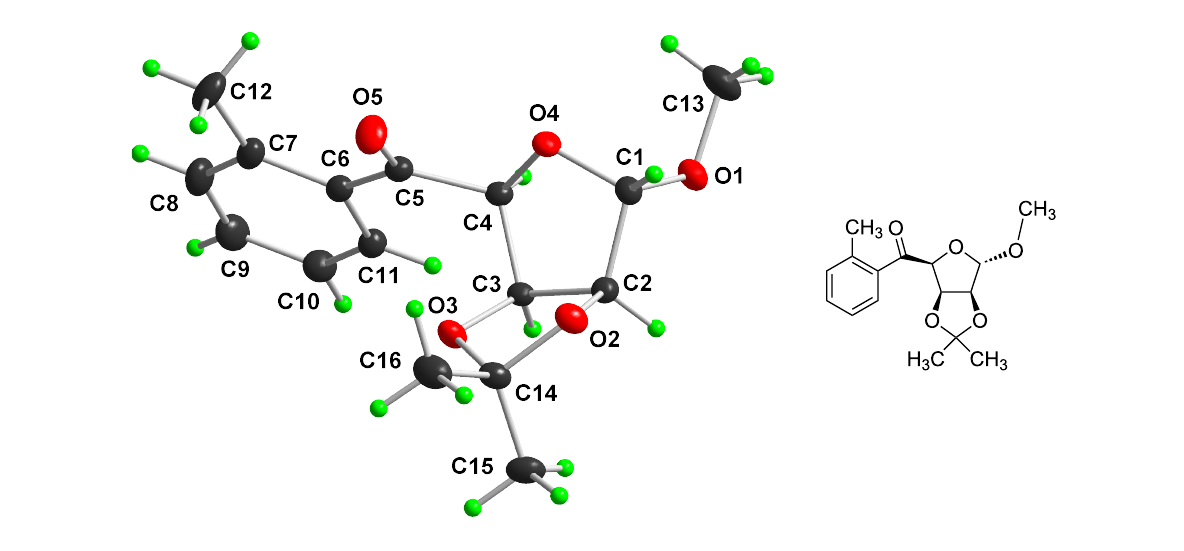
Figure 1: Molecular structure (DIAMOND drawing with adjacent ChemDraw image) of o -tolyl derivative 8 . Atomic displacement ellipsoids are drawn at 30% probability level and H atoms are shown as small spheres of arbitrary radii.